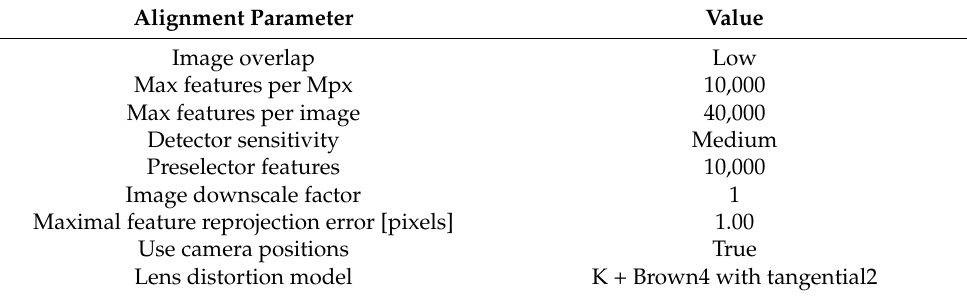
Table 2. Alignment settings in RealityCapture photogrammetric software. Alignment